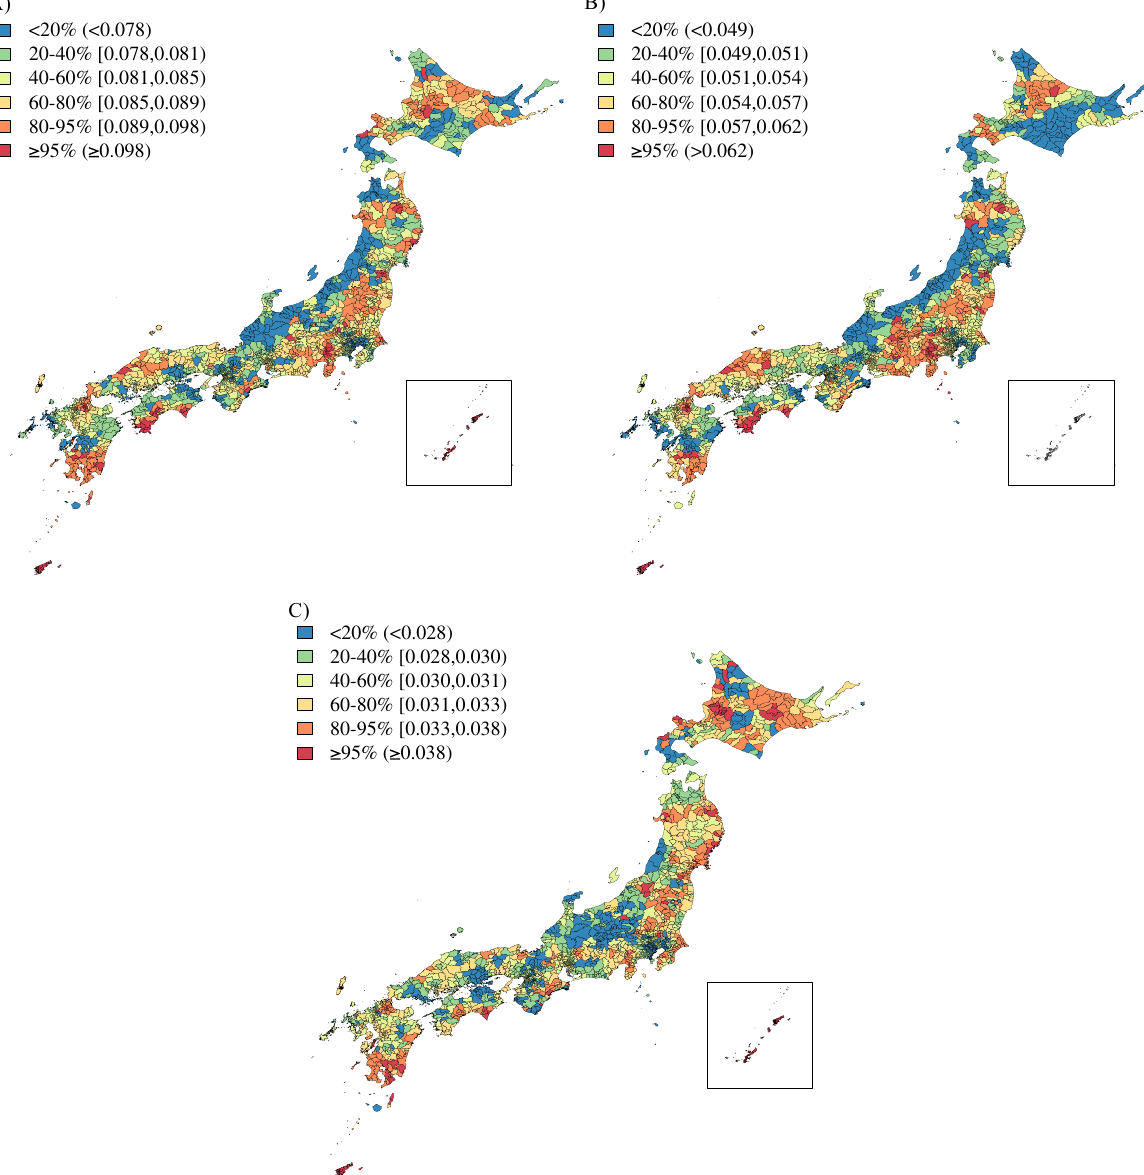
Figure 3. Empirical Bayes estimates of age-adjusted incidence rate of LBW ( A , left), LBW term ( B , center) and LBW pre ( C , right) in Japan: color scale indicates